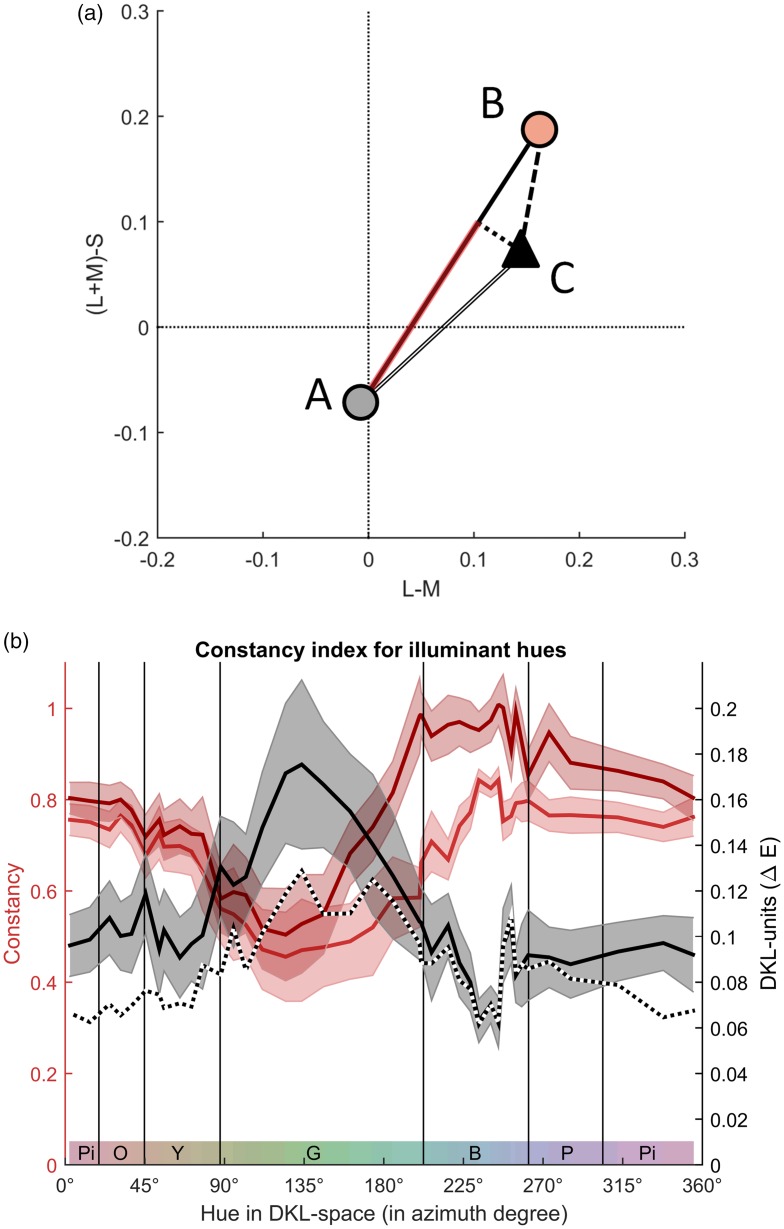
Colour constancy. (a) Illustration of the calculation of colour constancy measures. The grey disk A depicts the neutral illumination colour, the orange disk corresponds to the respective chromatic illuminant colour B, and the black triangle to the achromatic match C. The colour constancy index (CCI) is the distance BC divided by AB. The Brunswick ratio (BR) consists of the projection from AC to AB (red line) divided by AB. (b) The colour constancy measures obtained in our study (red y-axis on the left) as a function of azimuth (x-axis). The dark red curve shows the Brunswick ratio and the light red curve shows the Colour Constancy Index. The black curve and the black-and-white dotted curve correspond to the adjustment error (i.e., BC in (a)) and to interobserver variation (see text for explanation). The corresponding black y-axis on the right represents Euclidean distances in DKL-space. Note that the data along the solid black curve correspond to the length of the black lines in Figure 3(a) and form the basis of the CCI (red curve).